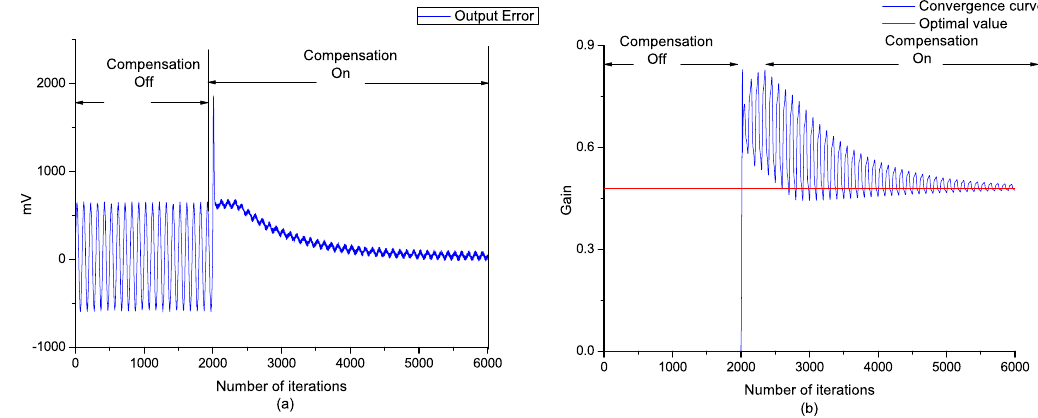
Figure 7. ( a ) Time domain steepest descent (TDSD) convergence curve of the measurement signal; ( b ) TDSD convergence curve of the positioner gain. TDSD convergence curve of the positioner